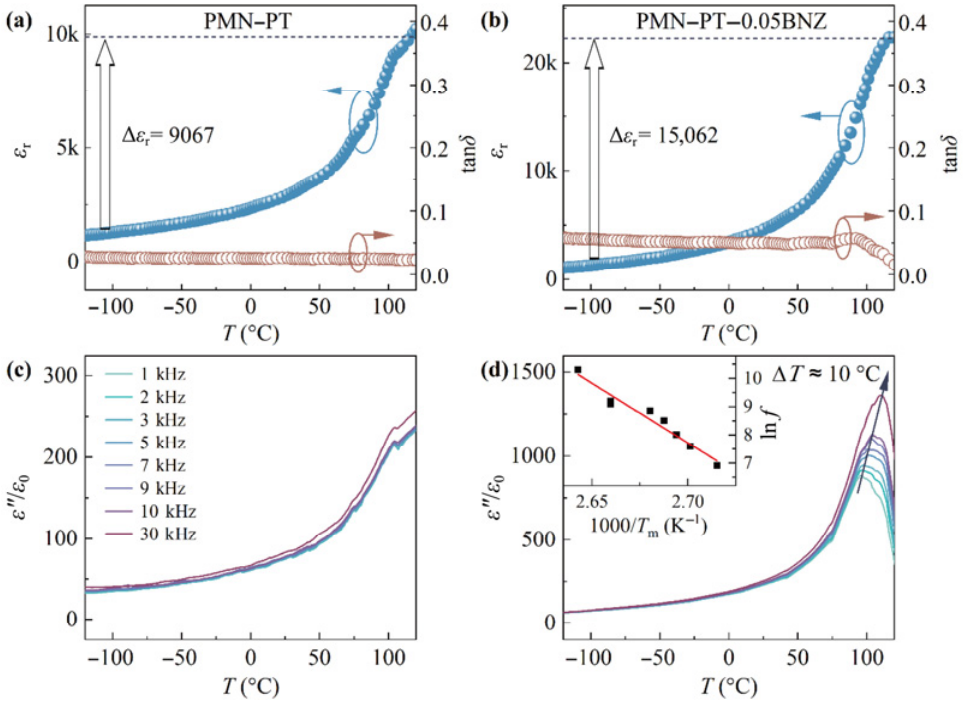
Fig. 5 Cryogenic dielectric permittivity and tan δ of (a) unmodified PMN–PT and (b) PMN–PT–0.05BNZ ceramic at 1 kHz. ε '' / ε 0 as a function of temperature and frequency for (c) unmodified PMN–PT and (d) PMN–PT–0.05BNZ ceramic; the inset in (d) is variation of ln f vs. 1000/ T m for PMN–PT–0.05BNZ ceramic. Note: f is the measurement